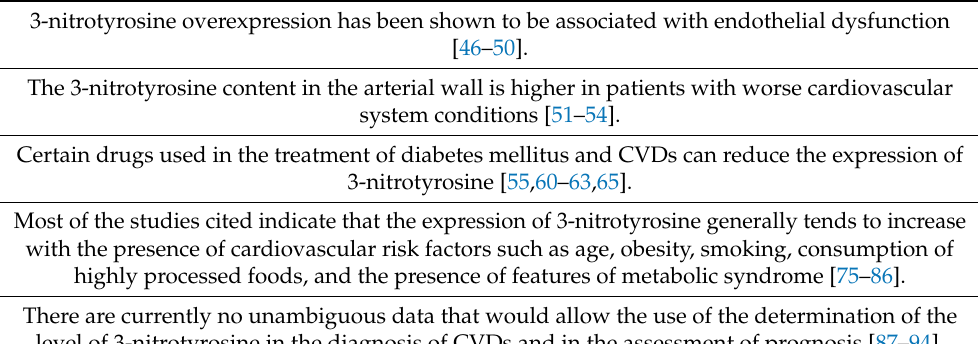
Table 2. Associations between 3-nitrotyrosine and cardiovascular disease—the most important findings. 3-nitrotyrosine overexpression has been shown to be associated with endothelial